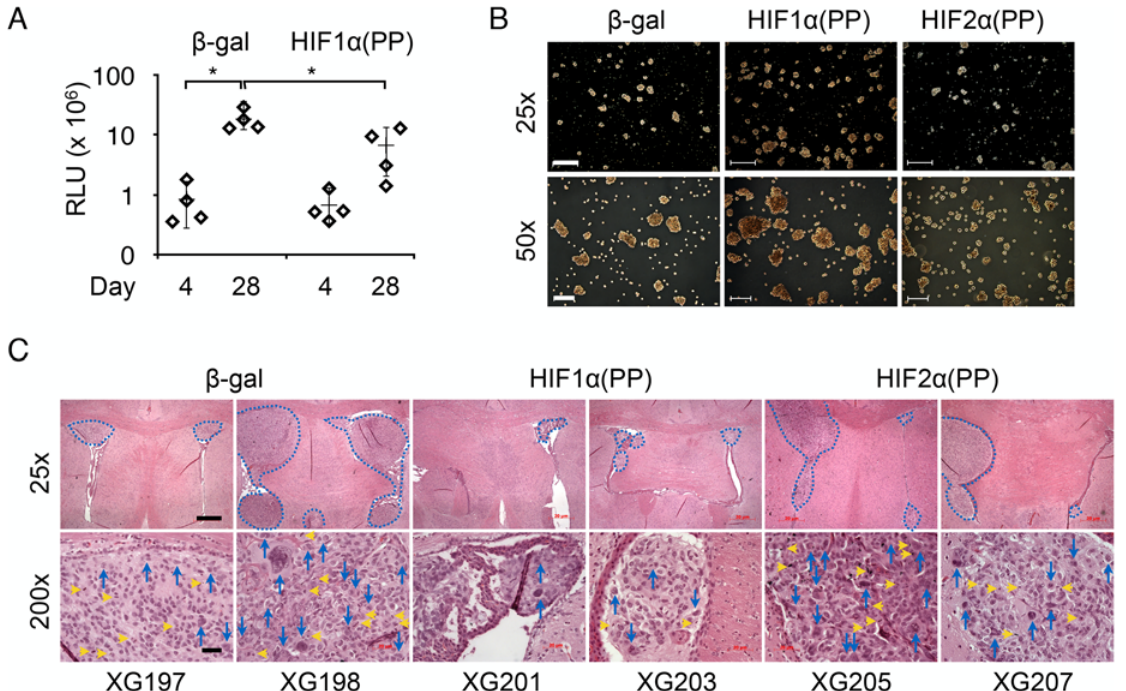
Fig 6. Transient expression of HIF1 α (PP) inhibited intracranial tumor growth. (A) U-87 MG cells were induced for 2 days prior to intracranial injections. Tumor volumes, plotted in a log scale, decreased significantly from HIF1 α (PP) in reference to β -gal. (B) After infection with lentiviruses expressing gene products as indicated, GSC20 cells were grown in neurobasal-A medium and images of tumor spheres were captured at 25× and 50× magnifications, with scale bars of 1 mm and 400 μ m, respectively. (C) Representative tumor lesions from 2 individual mice of each group are presented at 25× and 200× magnifications, with scale bars of 1 mm and 100 μ m, respectively. Tumor lesions are demarcated in dash lines. Mitoses are indicated by yellow arrowheads and multi-nucleation by blue arrows.